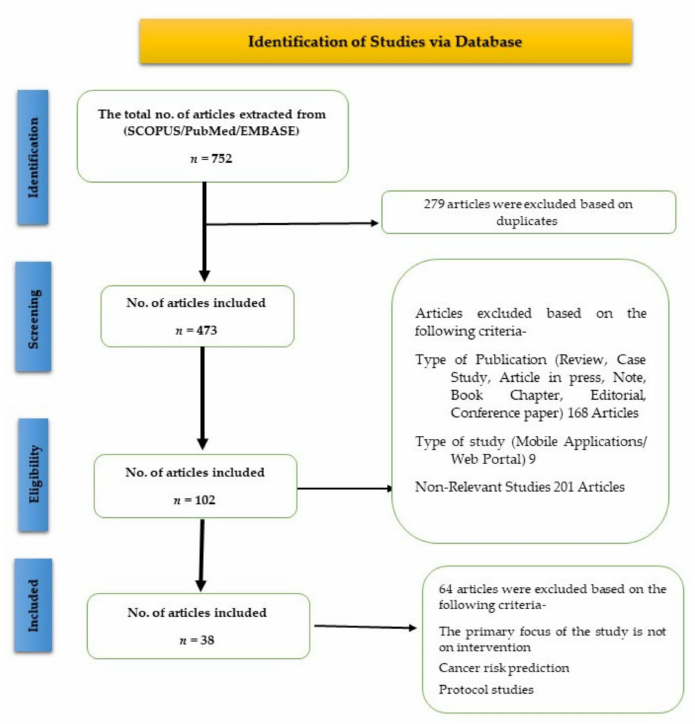
Figure 1. PRISMA flow diagram of the screening and selection of